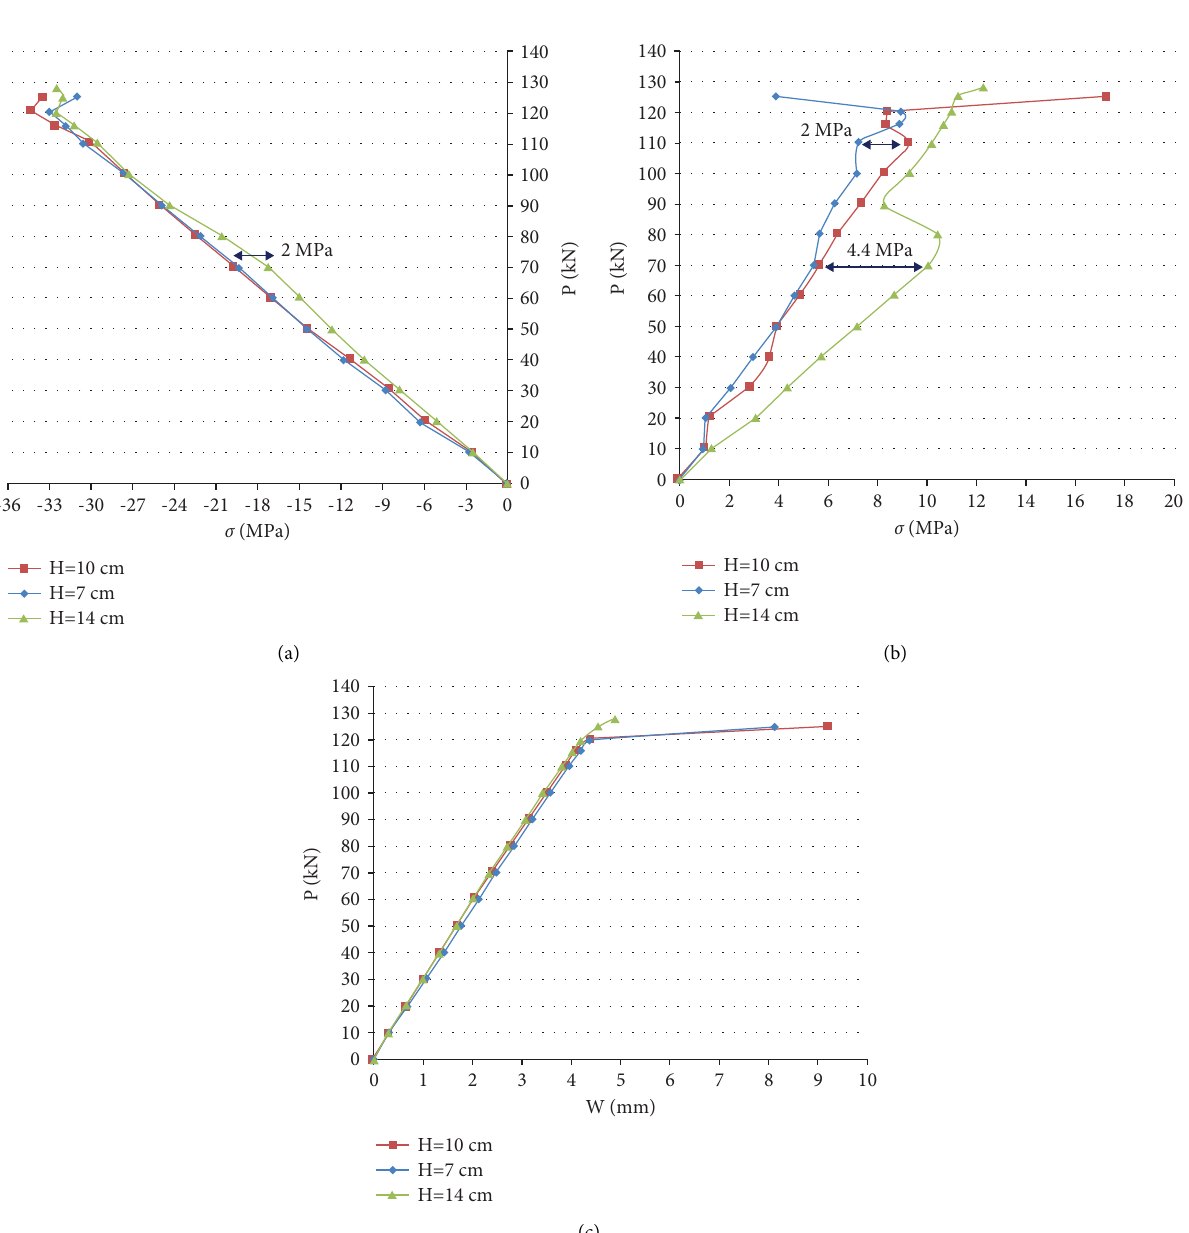
Figure 24: Relationship between load and stress, as well as between load and vertical displacement (efect of the thickness of the SFC layer): (a) relationship between load and compressive stress, (b) relationship between load and tensile stress. (c) the relationship between load and